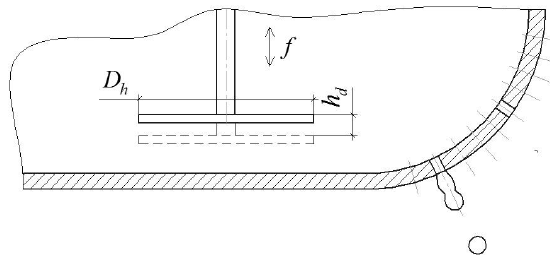
Figure 2. Schematic diagram of disc oscillator and perforated bottom vessel.